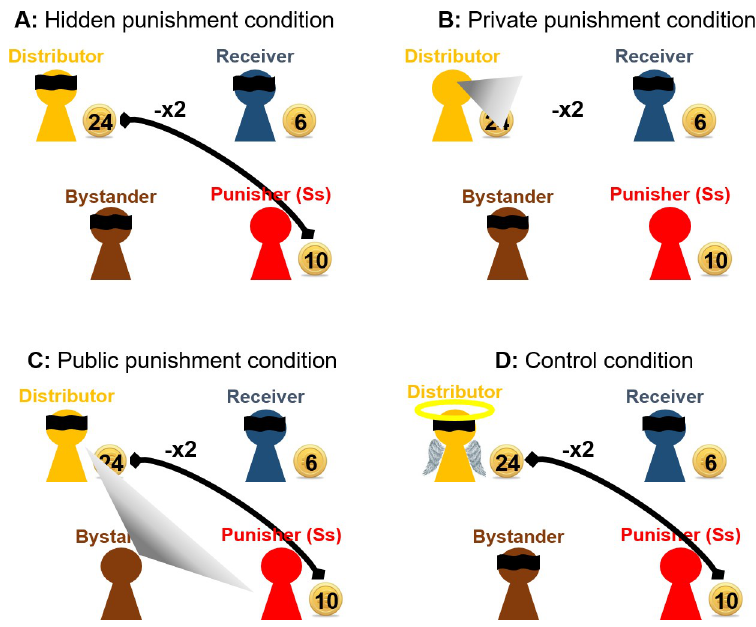
Fig 2. Experimental design. To isolate the unique effects of punishment motives (retribution vs. special prevention vs. general prevention) on the punisher’s decision, the distributor’s and bystander’s knowledge of whether and to what extent punishment had occurred was manipulated: (A) In the hidden punishment condition , neither the distributor nor the bystander learned about the punishment. (B) In the private punishment condition , the distributor (but not the bystander) learned about the punishment. (C) In the public punishment condition , the bystander (but not the distributor) learned about the punishment. (D) In the control condition , the distributor acted fairly towards the receiver (i.e., giving half of their piggy banks to the receiver) but still ended up with more coins than the receiver due to luck. Punishment in this condition may be interpreted as a decision to reinforce equality (rather than actually “punish” the distributor for a norm